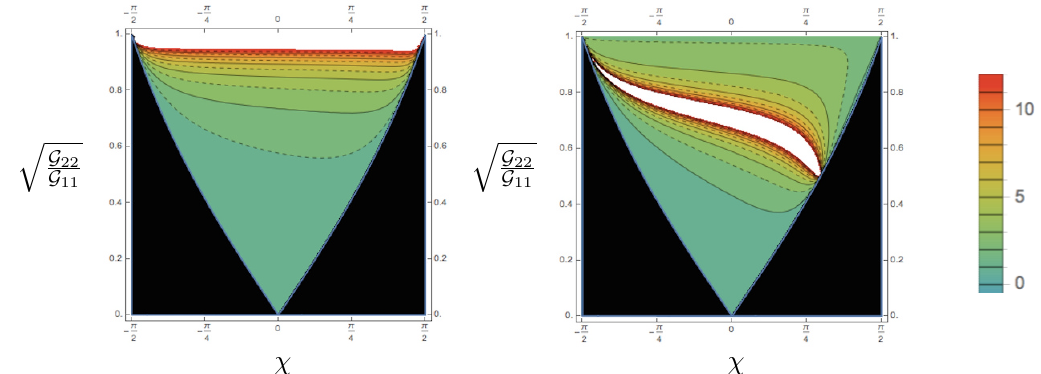
Figure 1 . Contour plot for e(cid:11)ective axion decay constant f (cid:24) in (2.12) as a function of the moduli- p dependent quantities (cid:31) and G 22 = G 11 with discrete parameters k 1 = k 2 = n 1 = n 2 (left) and k 1 = k 2 = (cid:0) 2 n 1 = (cid:0) n 2 (right). Black regions correspond to unphysical values for f (cid:24) (due to a negative value for (cid:21) (cid:0) ), while the physical values follow the color-coding from small (green) to large (red), as indicated by the color bar on the right hand side. White regions correspond to values for p the axion decay constant with f (cid:24) (cid:21) O (10) G 11